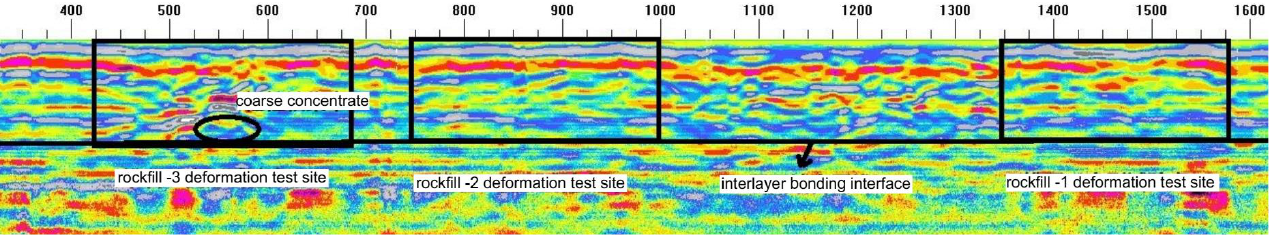
Figure 8. Digital mixing and intelligent dynamic control platform for cemented dams. The authors proposed a dual - strength and band - controlled mix ratio design method [17]. Despite the variation in the strength of the cementitious material, the overall safety